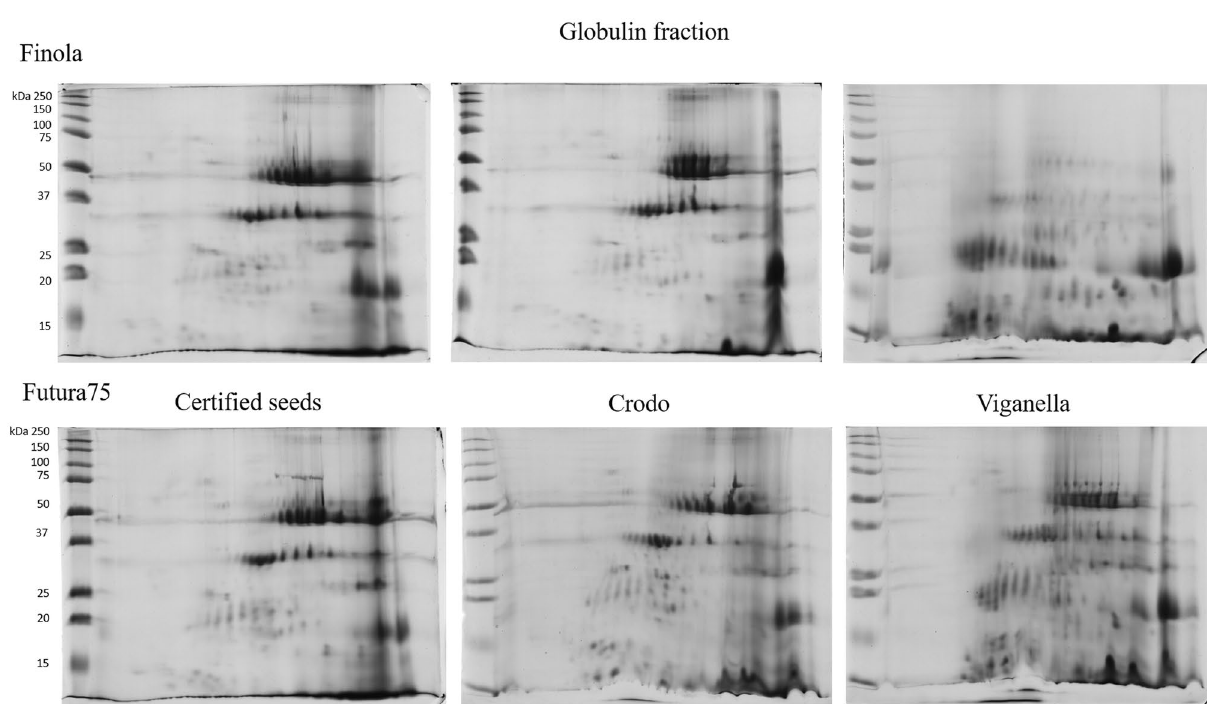
Figure 2. 2D-PAGE of globulin fraction of Finola (on the upper part of the image) and Futura 75 (on the lower part of the image) certified seeds (on the left), or obtained from the experimental fields of Crodo (middle) and Viganella